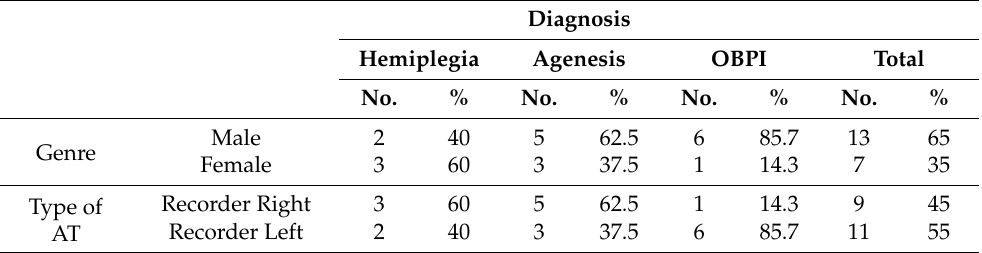
Table 1. Social profile of the